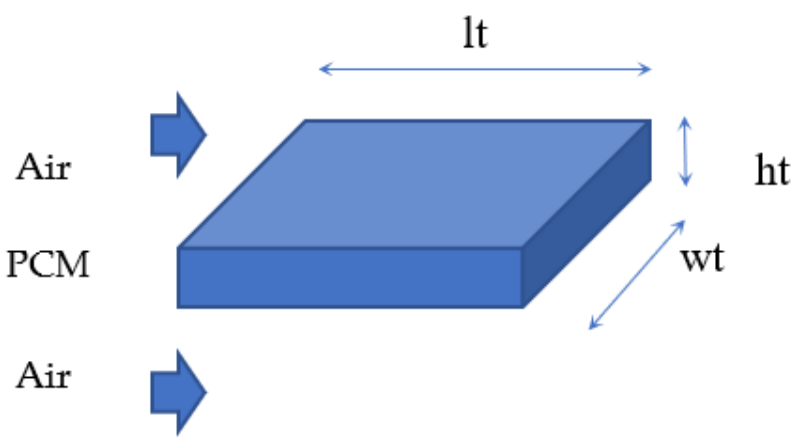
Figure 3. Validation of the rectangular container with CaCl 2 ·6H 2 O.